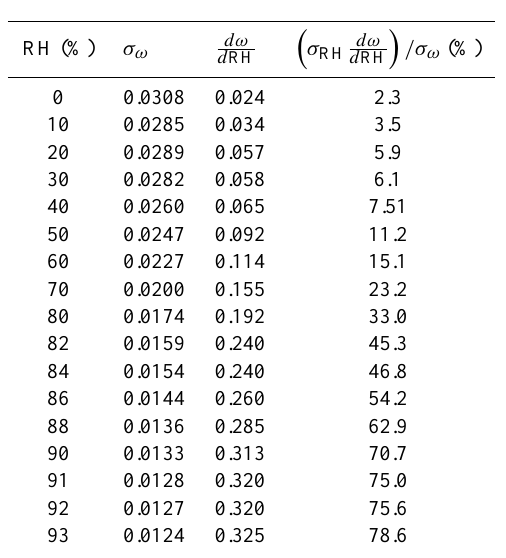
Table 2. Uncertainties of the input parameters in the Monte Carlo simulations.